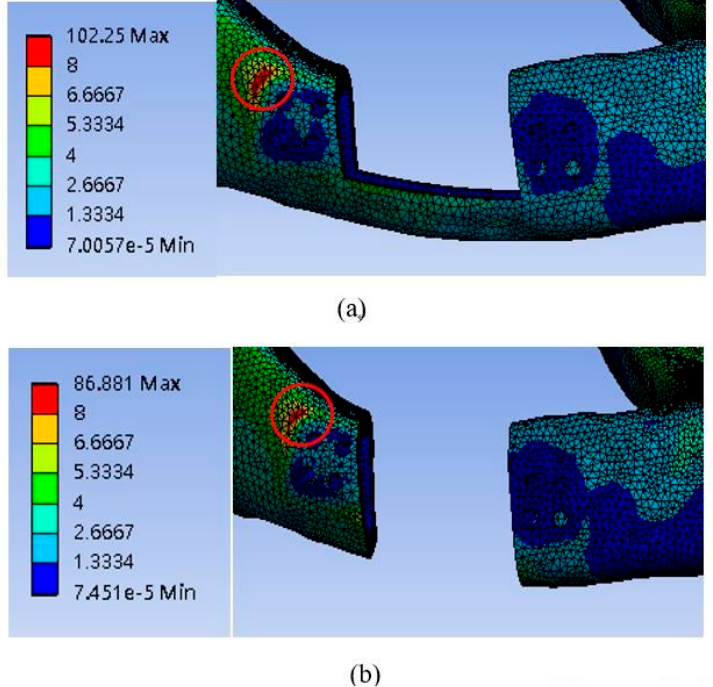
Figure 6. Von Mises stress distribution of the cortical bones near the 3D-printed implant in ( a ) Model 1 (length: 20 mm; thickness: 0.8 mm) and ( b ) Model 2 (length: 20 mm; thickness: 0.8 mm) (Unit: MPa). Table 3. High-stress values of the mandibular cortical bones, the cortical bone near the 3D-printed